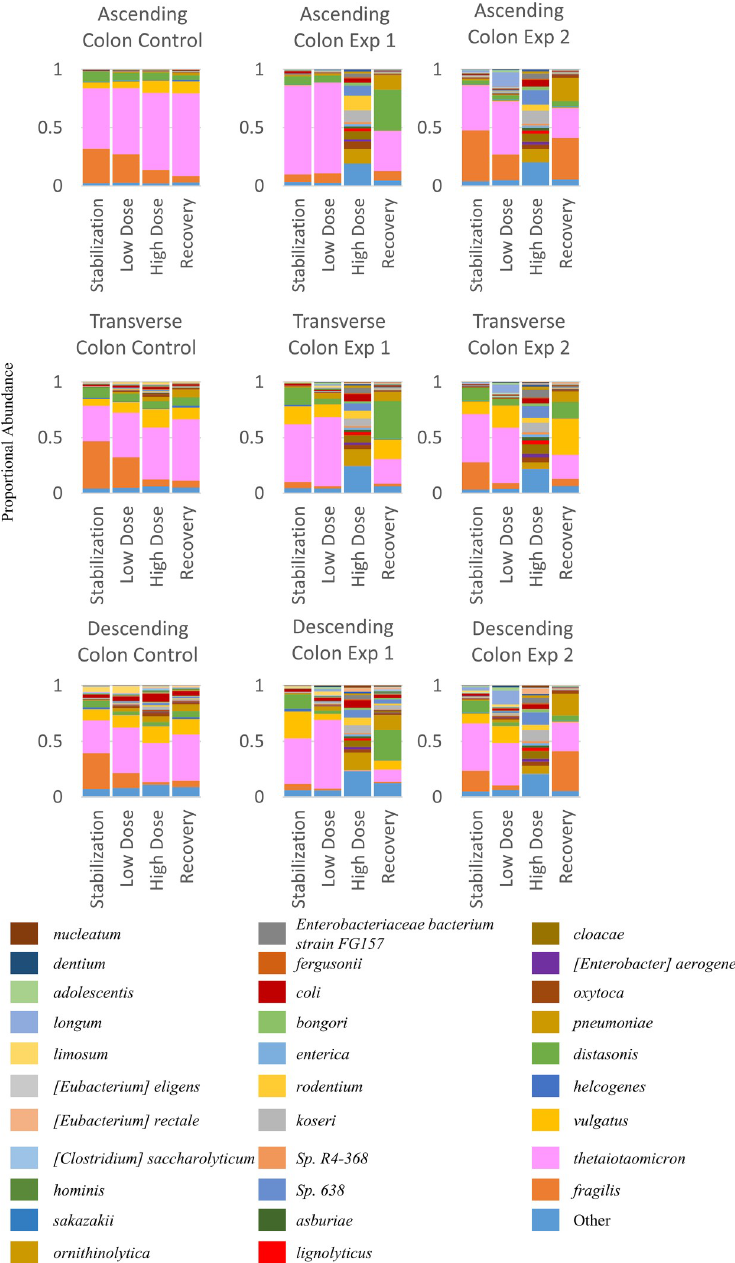
Fig 4. Bacterial community population data based on shotgun metagenomic sequencing at the species level. Unit 1 (A1, T1, D1) on the left panel are the control groups. Middle and right panels are the experimental groups (n of 2). thetaiotaomicron (pink), whose population dropped drastically after the high dose period, but showed an ability to recover towards normal population levels during the recovery period. We see similar, though less drastic drops in population in other Bacteroidetes species, such as Bac- teroidetes fragilis (orange). Conversely, we see a proportional increase in abundance with many of the Proteobacteria species during the High Dose period, with a reduction back towards control population levels during the recovery period. However, one species, Klebsiella